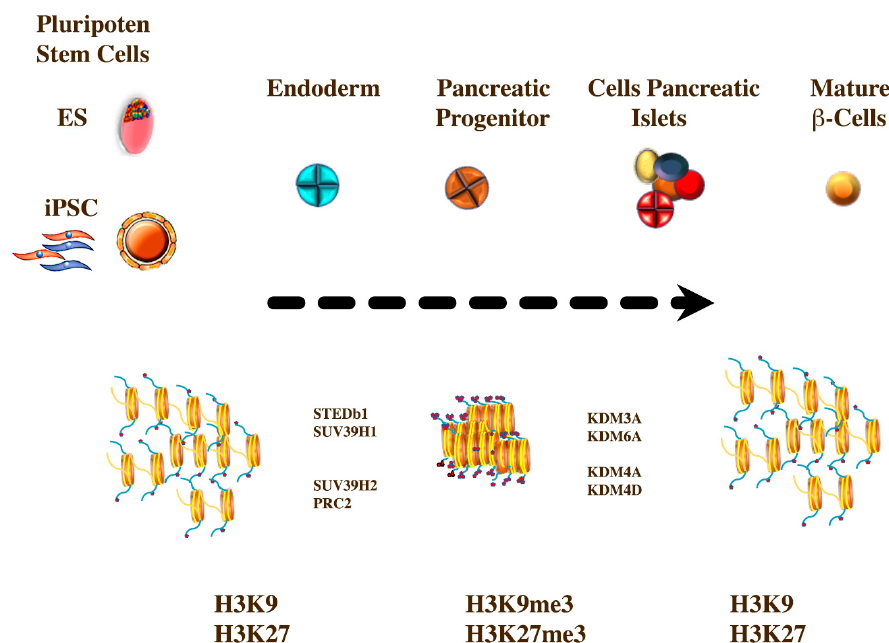
Figure 4. Graphic representation of the influence of the methylation pattern on pancreas development. The development of pancreatic islet cells are subject to a number of epigenetic variations. The modifications of the methylation of histones 3 in lysine residues 9 and 27 (H3K9 and H3K27) stand out. The highest number of genes marked by H3K9me3 is detected at the germ layer stage in endoderm. SET domain bifurcated histone-lysine methyltransferase (STEDb1), Suppressor of Variegation 3-9 Homolog 1, -2 (SUV39H1), -SUV39H2 and the Polycomp complex (PRC2) produce hypermethylation of the lysine residues (H3K9me3 and H3K9me3). After the differentiation of the Endocrine pancreas cells. Progressive loss of H3K9me3 and H3K27me3 at lineage-specific genes mediated by lysine demethylases, KDM4A, -KDM4D, -KDM3A, -KDM6A.